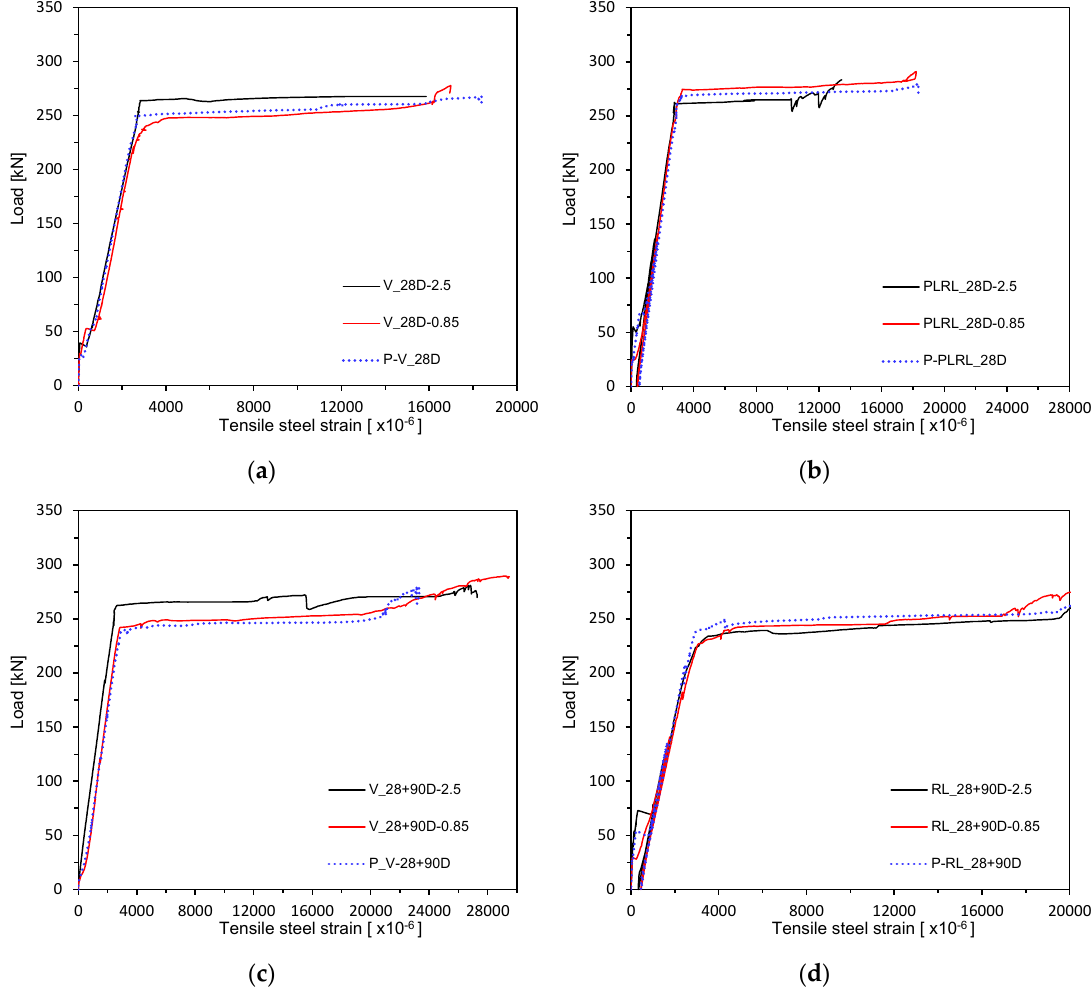
Figure 14. Load–steel reinforcement strain measurement by loading conditions: ( a ) V_28D series; ( b ) PLRL_28D series; ( c ) RL_28D series; ( d ) RL_28 + 90D series.